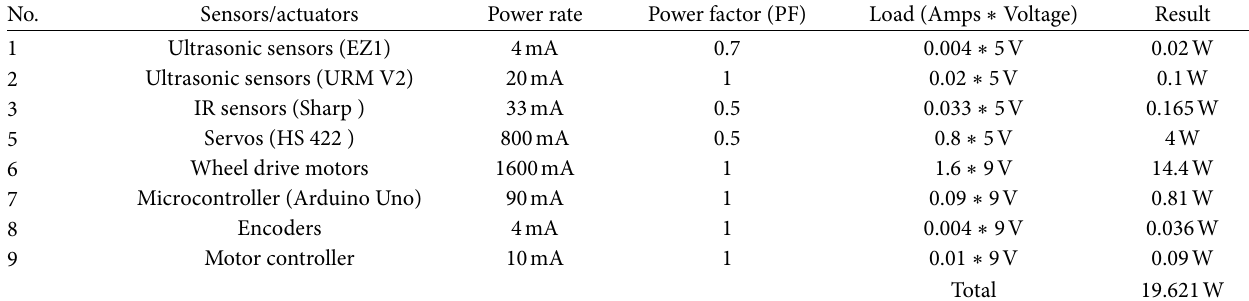
Table 2: Components and loads in robot 1.